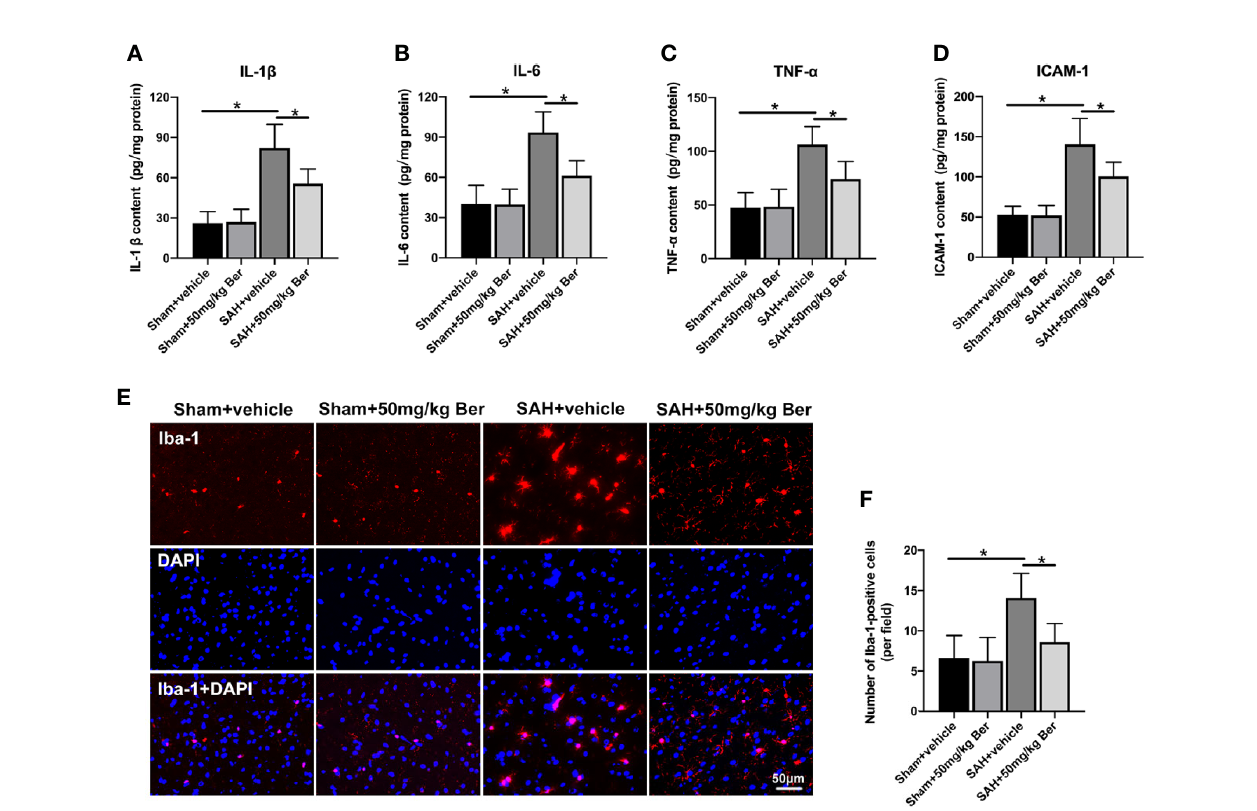
FIGURE 2 | Effects of berberine on in fl ammatory response after SAH. (A-D) Quanti fi cation of IL-1 b (A) , IL-6 (B) , TNF- a (C), and ICAM-1 (D) protein expressions in all groups. n = 6 per group. (E) Representative photomicrographs of immuno fl uorescence staining for Iba-1. (F) Quantitative analysis of the Iba-1 immuno fl uorescence staining. n = 6 per group. Bars represent the mean ± SD. * P <